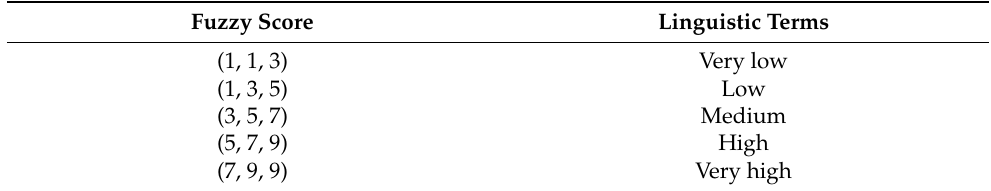
Table 2. Fuzzy score and linguistic terms. Source: own